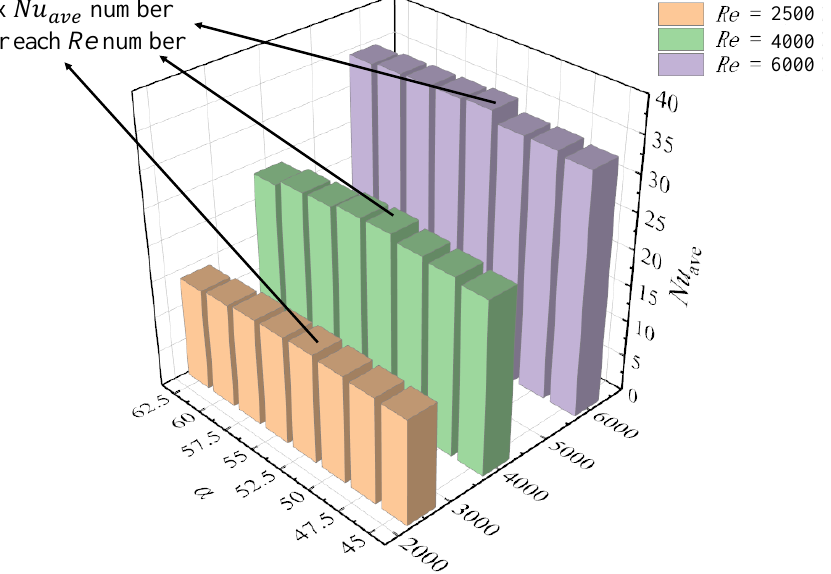
Figure 27. Nu ave vs. shape factor ( Re in = 2500, A = tan 𝛼° , q = 1 kW/m 2 , and 29% Xe).